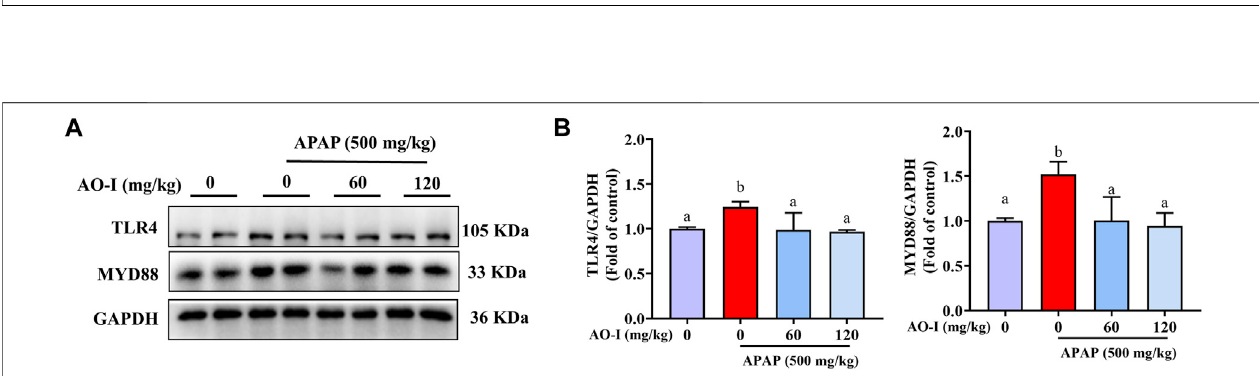
Frontiers in Pharmacology |